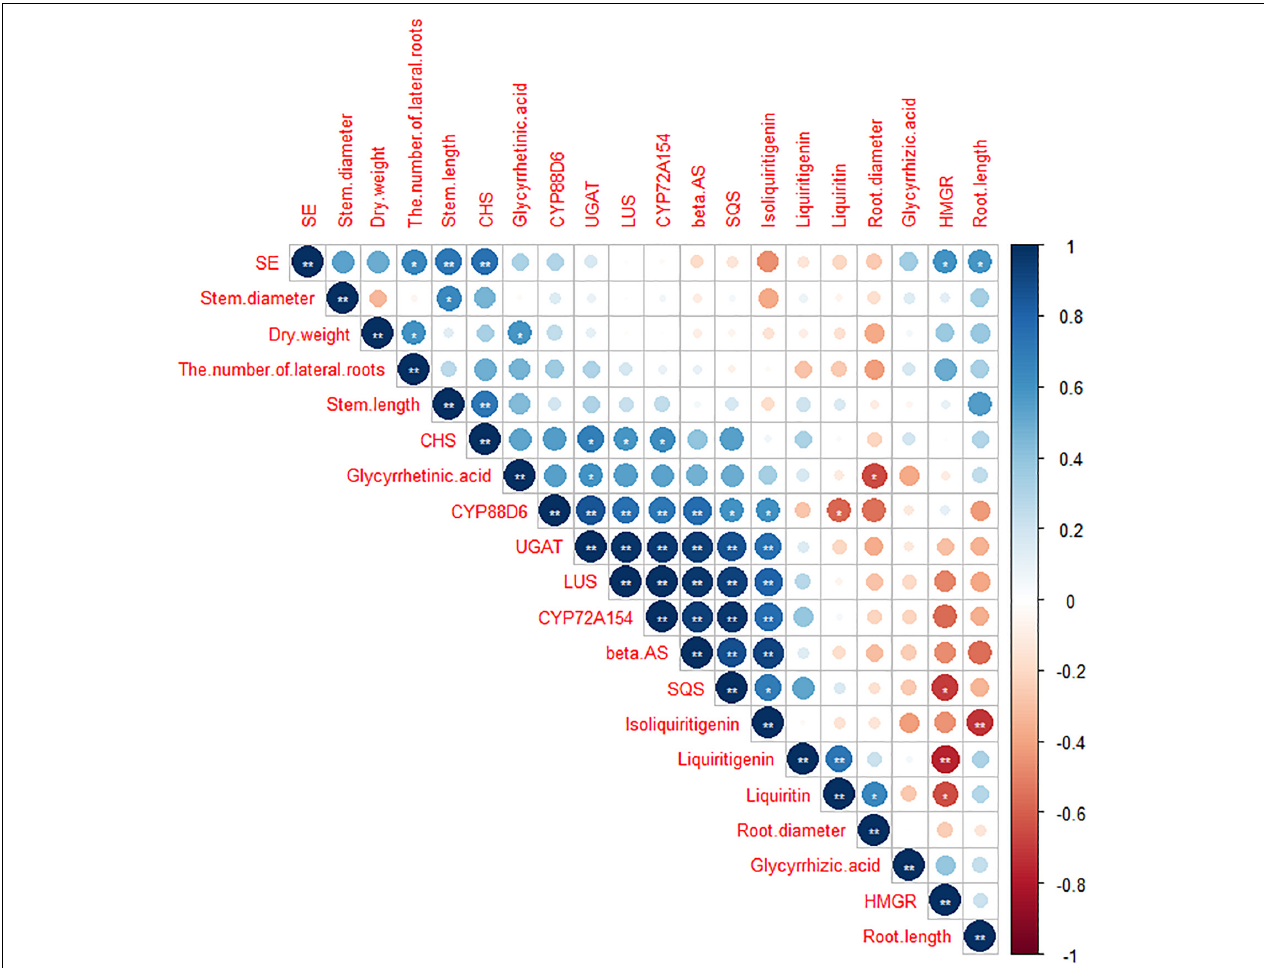
FIGURE 8 | Correlation analysis among seedlings growth, medicinal ingredients, and secondary metabolites pathway in G. uralensis under four treatments. **Correlation is significant at the 0.01 level (two-tailed). *Correlation is significant at the 0.05 level